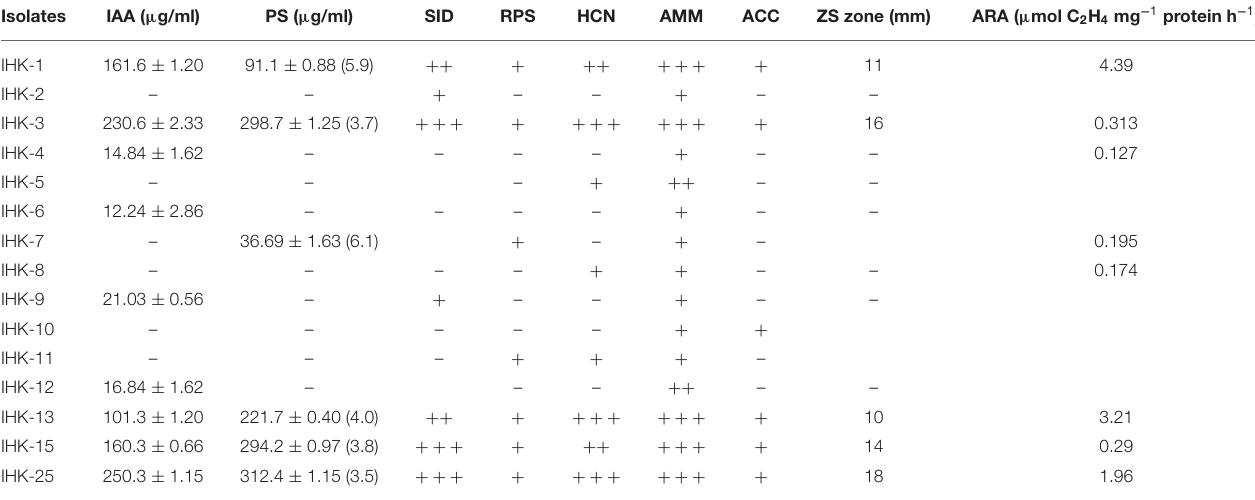
TABLE 2 | PGP traits of the bacteria isolated from rice rhizosphere.